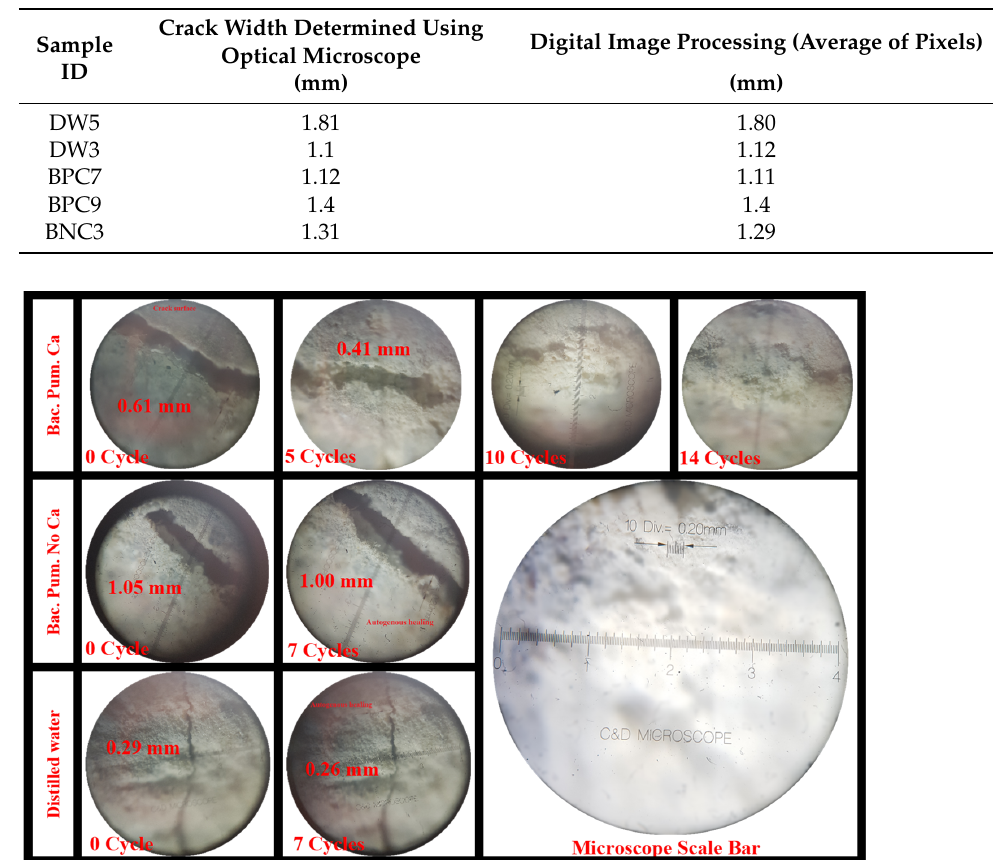
Figure 10. Crack healing under an optical microscope